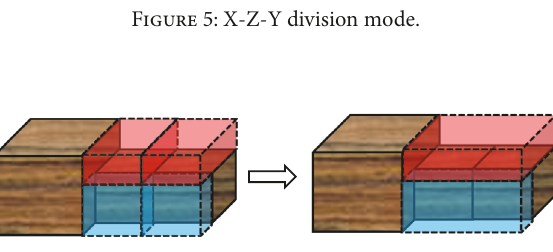
Figure 6: Right-and-left space